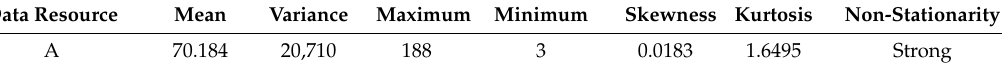
Figure 2. Location of the intersection in Chongqing. Table 1. Data characteristics (A).